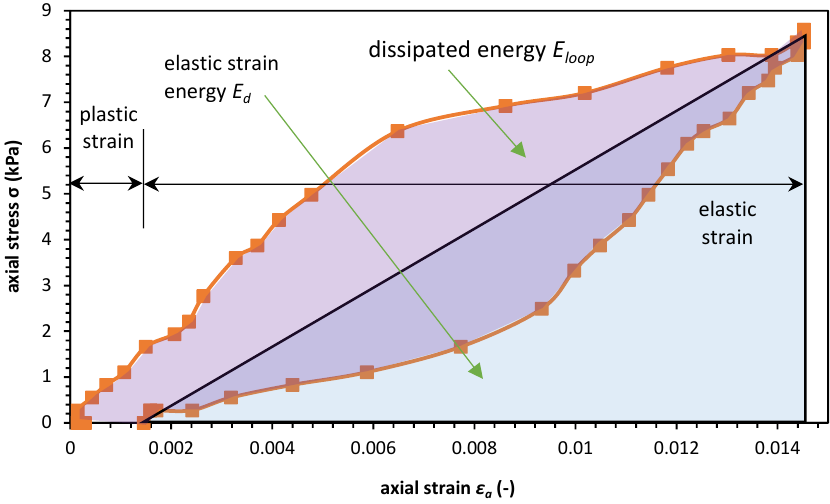
Figure 3. Schema of dissipated energy and elastic strain energy in one cycle.